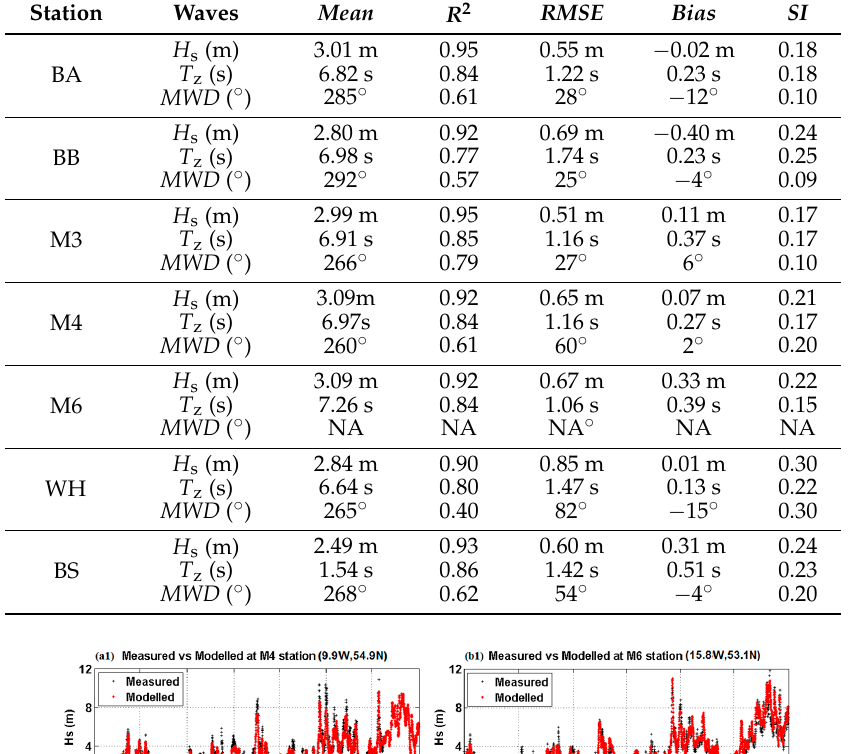
Table 2. Summary of coarse Ireland (CI) model validation values and measured mean values for 2008–2013. NA indicates non-available data. MWD : mean wave direction.